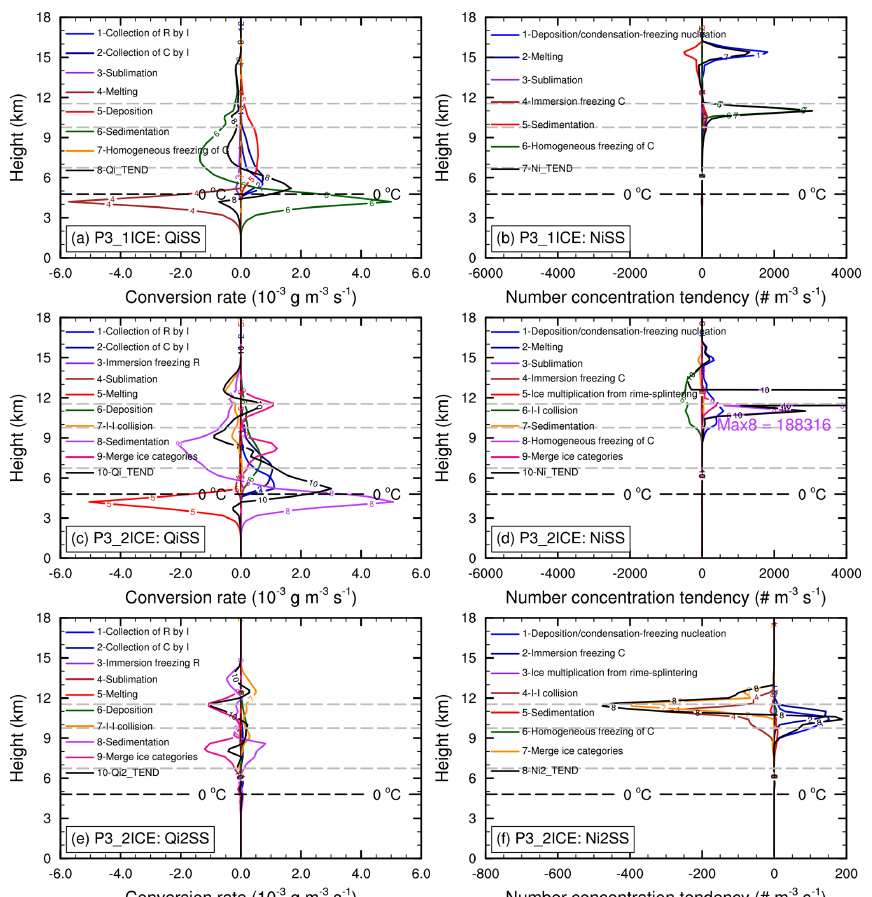
Figure 14. Vertical profiles of (a, c, e) averaged mass conversion rates (solid lines, 10 − 3 gm − 3 s − 1 ) and (b, d, f) averaged number concen- tration tendency (solid lines, #m − 3 s − 1 ) of ice categories due to different microphysical processes in (a, b) P3-1ICE and (c–f) P3-2ICE. Only the profiles whose column-maximum conversion rates are larger than 10 − 6 gm − 3 s − 1 and column-maximum number concentration tendencies are larger than 1m − 3 s − 1 are shown in (a, c, e) and (b, d, f) , respectively. The total microphysics tendencies of first ice category ( a, c Qi_TEND; b, d : Ni_TEND) and second ice category ( e : Qi2_TEND; f : Ni2_TEND) are shown by black solid curves. The horizontal thin black and gray dashed lines indicate the heights of 0, − 10, − 30, and − 45 ◦ C from bottom to top, respectively. The numbers of samples used to calculate the averages are shown in Table 1. C: ice; R: rain water; I: cloud